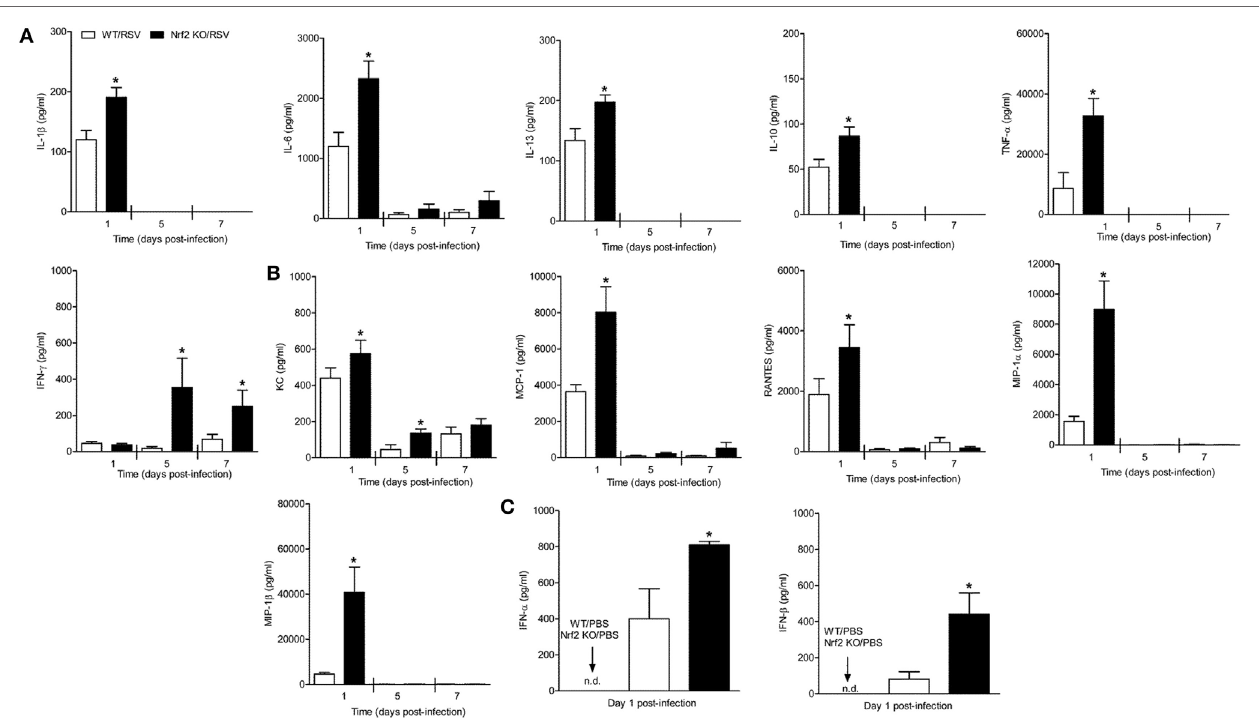
FigUre 5 | NF-E2-related factor 2 (Nrf2) gene deficiency is associated with increased secretion of cytokines chemokines and type I interferon (IFN) in response to respiratory syncytial virus (RSV) infection. Nrf2 KO and Nrf2 wild type (WT) mice were infected with RSV or PBS. The bronchoalveolar lavage samples were collected at different time points after infection and analyzed for cytokines (a) and chemokines (B) by Bio-Plex, and for type I IFN by enzyme-linked immunosorbent assays (c) . The bar graph represents mean ± SEM ( n = 3–6 mice/group). * p < 0.05 when compared with